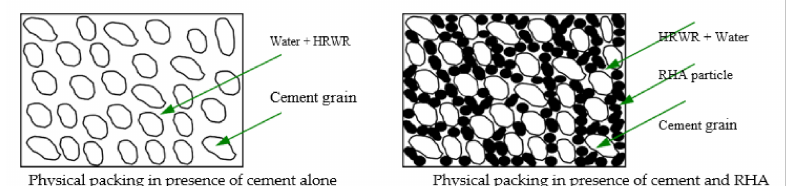
Figure 4. The micro-filling effect of RHA